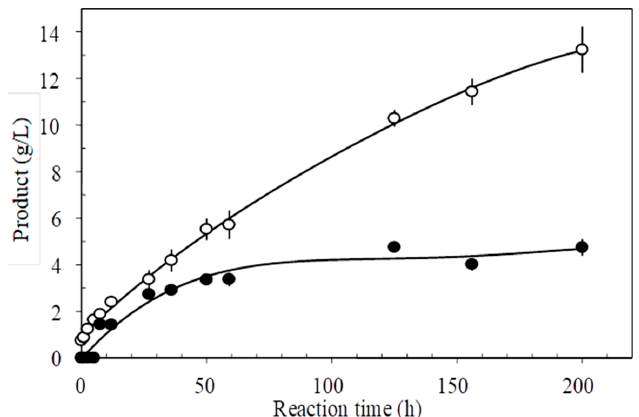
Figure 4. Progress of tert -butyl alcohol glucosylation by CGTase from Thermoanaerobacter sp. Open circles, α -glucoside derivative; filled circles, α -maltoside derivative. Reaction conditions: Soluble starch (30 g/L), 30% tert -butyl alcohol, 10 mM citrate buffer (pH 5.5), 0.4 U/mL CGTase (transglycosylation activity, EPS method), and 60 °C.